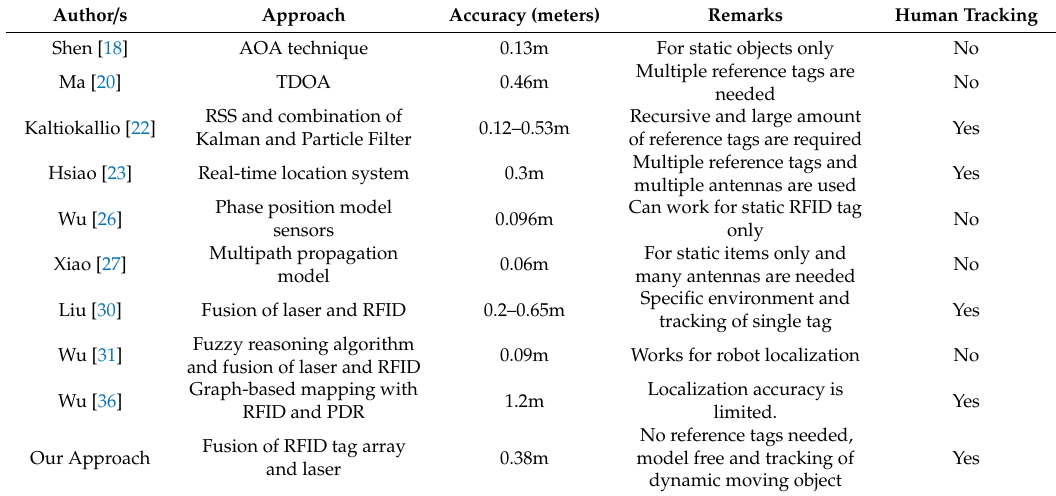
Table 1. Comparison of related work.